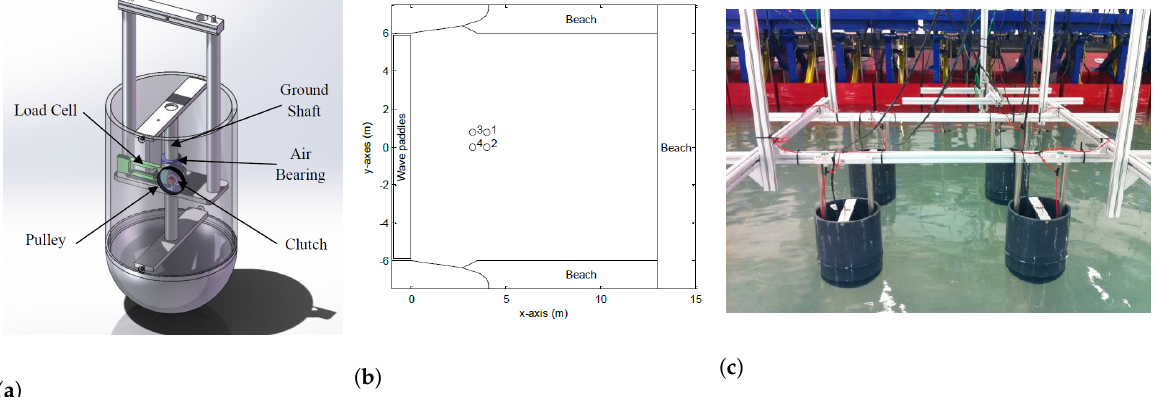
Figure 4. Experimental setup used by Lamont-Kane et al., reprinted with permission from Ref. [38], 2013, Lamont-Kane et al.: ( a ) WEC model; ( b ) QUB wave basin WEC array layout; ( c ) QUB wave basin